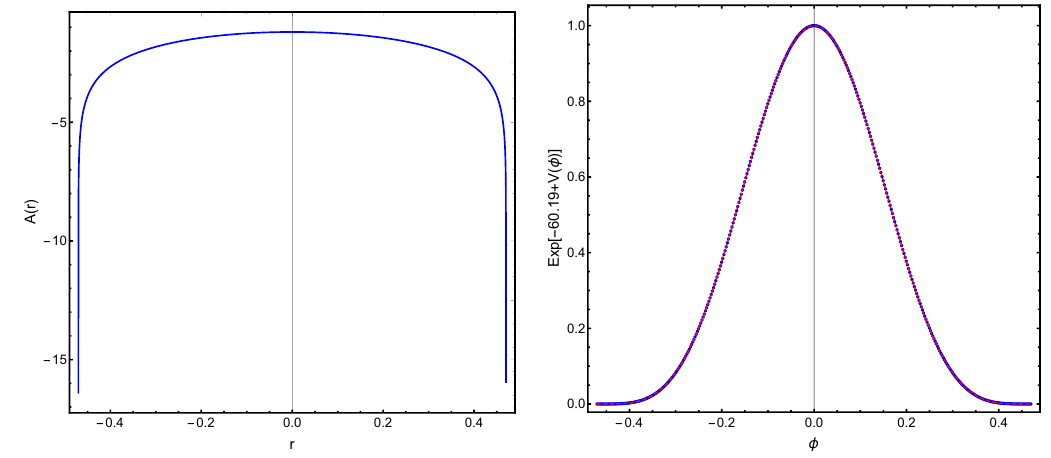
Figure 2 . Left: warp factor A ( r ) in presence of a linear scalar. The warp factor A diverges at r min and r max . Right: the blue line depicts the reconstructed potential of the scalar (cid:12)eld. The dashed red line depicts the (cid:12)t with an 10th order polynomial exp( (cid:0) 60 : 19+ V ( (cid:30) )) = 1 : 00 (cid:0) 8 : 12 (cid:30) 2 + 75 : 53 (cid:30) 4 (cid:0) 367 : 12 (cid:30) 6 + 940 : 42 (cid:30) 8 (cid:0) 1016 : 03 (cid:30) 10